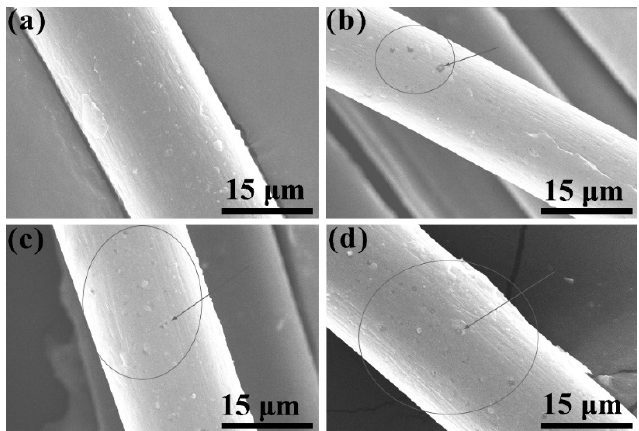
Figure 14. SEM micrographs of the surfaces of ( a ) pure POM fiber and POM / PLLA bicomponent fibers containing ( b ) 5, ( c ) 10, and ( d ) 20 wt % PLLA at the ultimate draw ratio after thermo-oxidation aging.